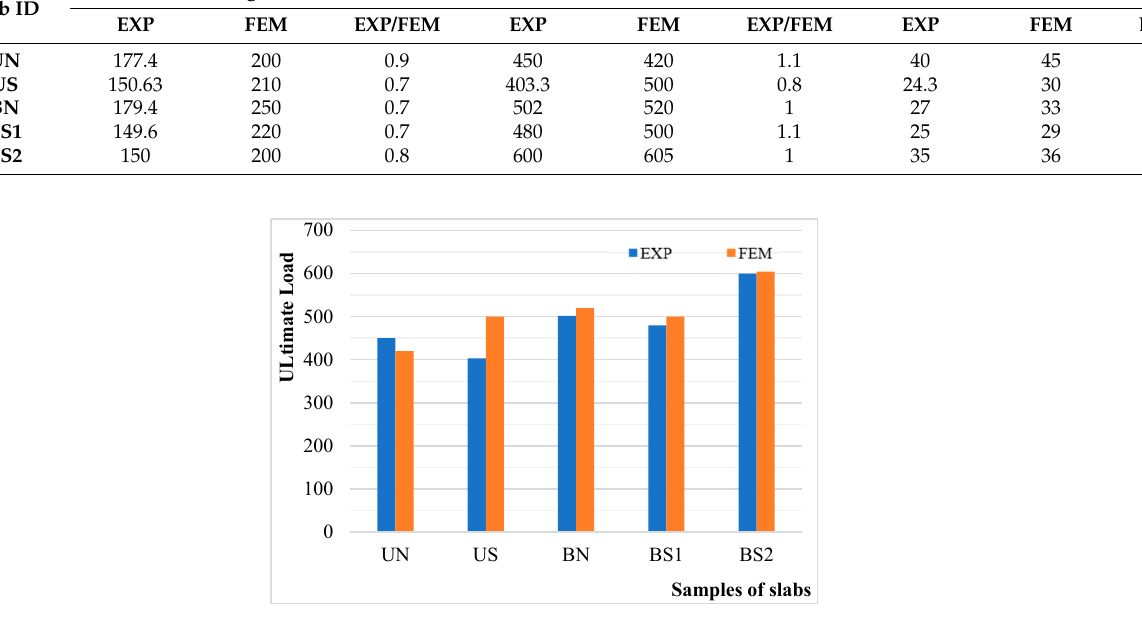
Table 4. Experimental and FEM of cracking load, ultimate load, and ultimate deflection.